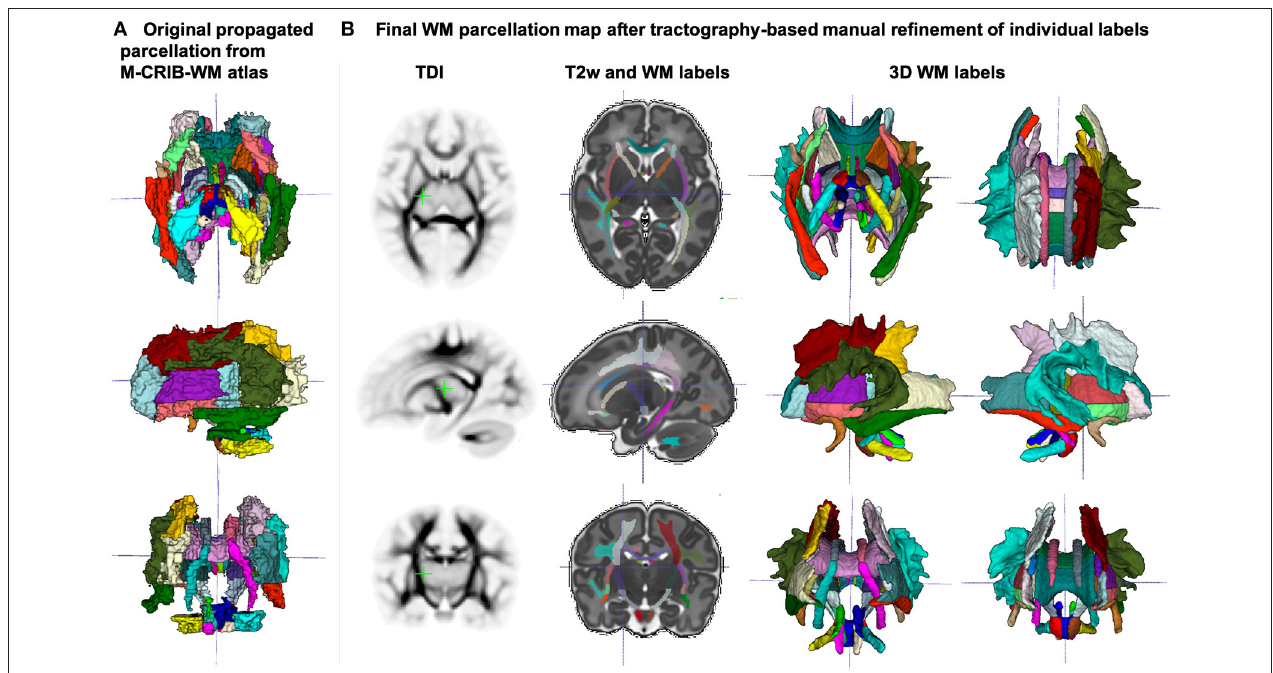
FIGURE 7 | (A) Original WM parcellation map propagated from the M-CRIB-WM atlas using T2w-guided registration. (B) Final WM parcellation map after tractography-based manual refinement in the atlas reference space. The 54 ROIs are based on the structures defined in the M-CRIB-WM atlas (Alexander et al., 2020). The corresponding TDI map highlights the WM pathway regions.